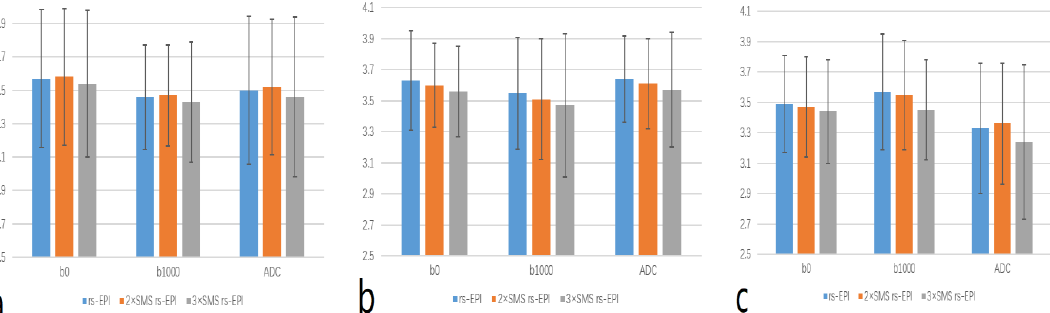
Figure 2. Comparison of qualitative evaluation metrics of the three EPI sequences. ( a ) lesion conspicuity; ( b ) overall image quality; ( c ) margin sharpness.